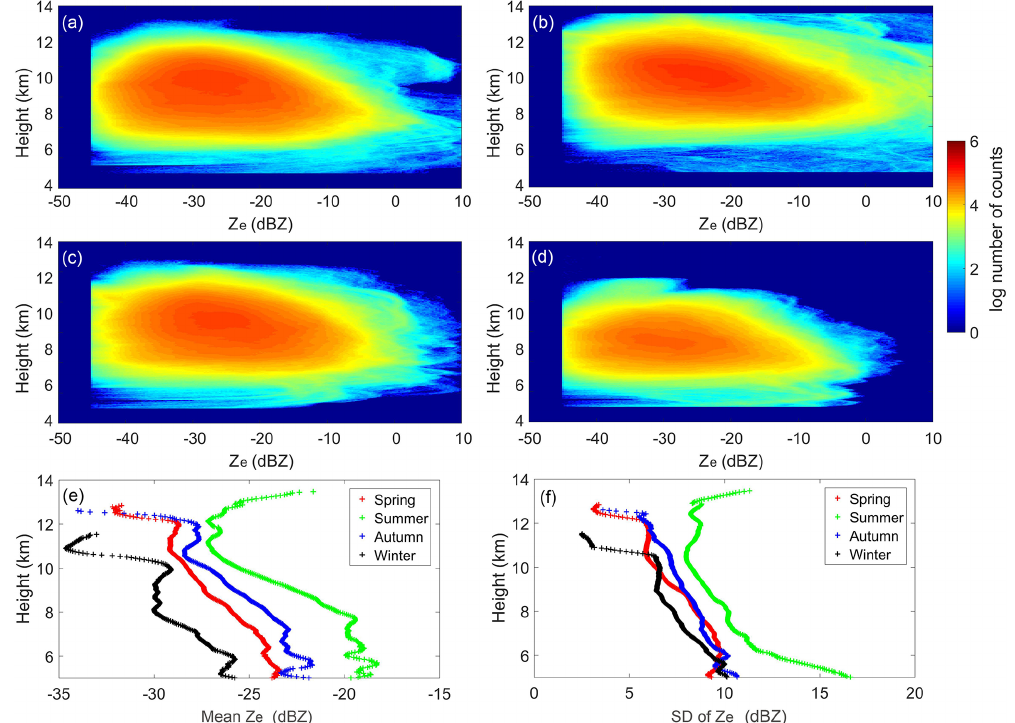
Figure 5. The frequency of reflectivity versus height in spring (a) , summer (b) , autumn (c) and winter (d) . Colors are the log number of the counts (calculated at 0.25dBZ and 30m intervals). The mean reflectivity calculated at various heights and the corresponding standard deviation (SD) are presented in panels (e) and (f) ,